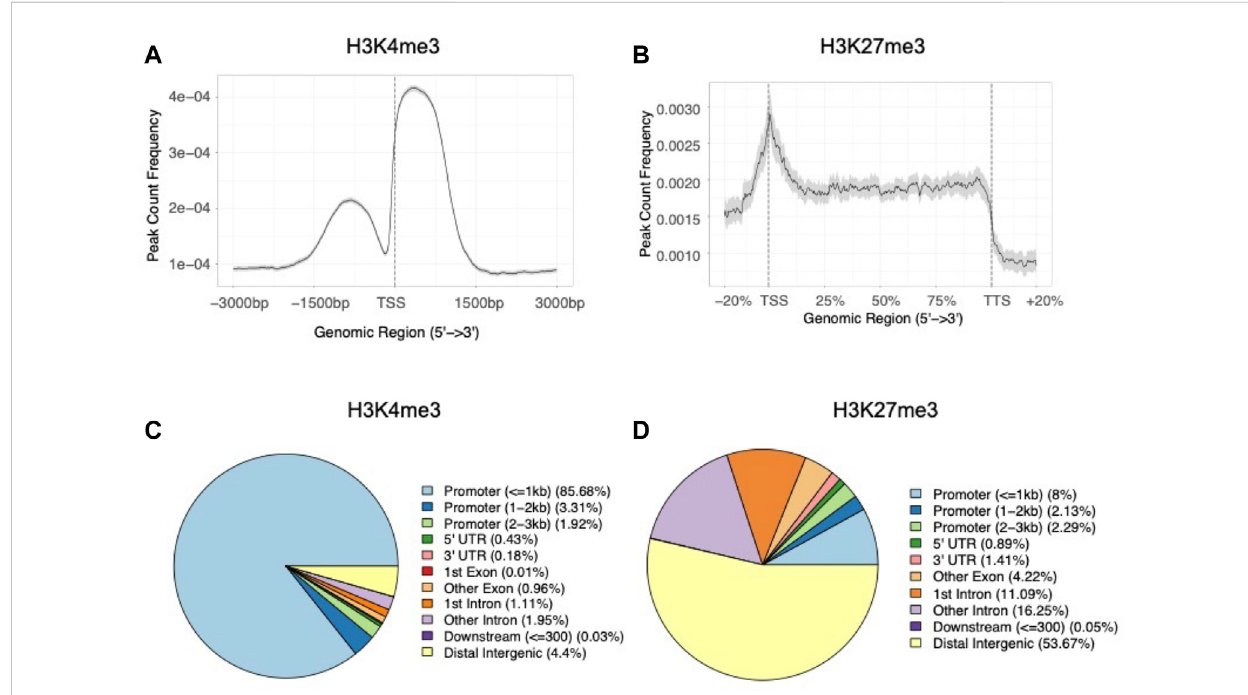
FIGURE 4 Distribution patterns of (A) average H3K4me3 peaks around TSS regions (±3 kb) and (B) average H3K27me3 peaks in gene body regions of the B. dorsalis genome. The proportion of genomic features of (C) H3K4me3 peaks and (D) H3K27me3 peaks compared with genomic